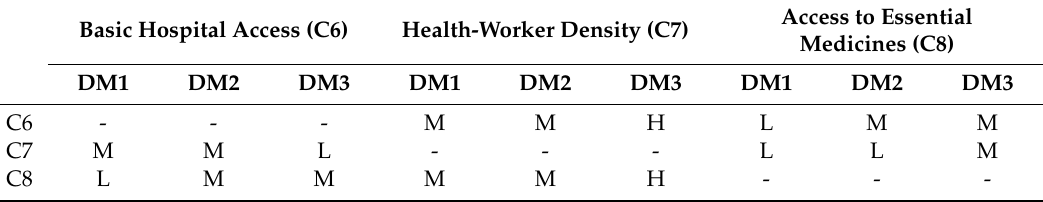
Table 7. Linguistic evaluations of decision makers for the dimension of service capacity and